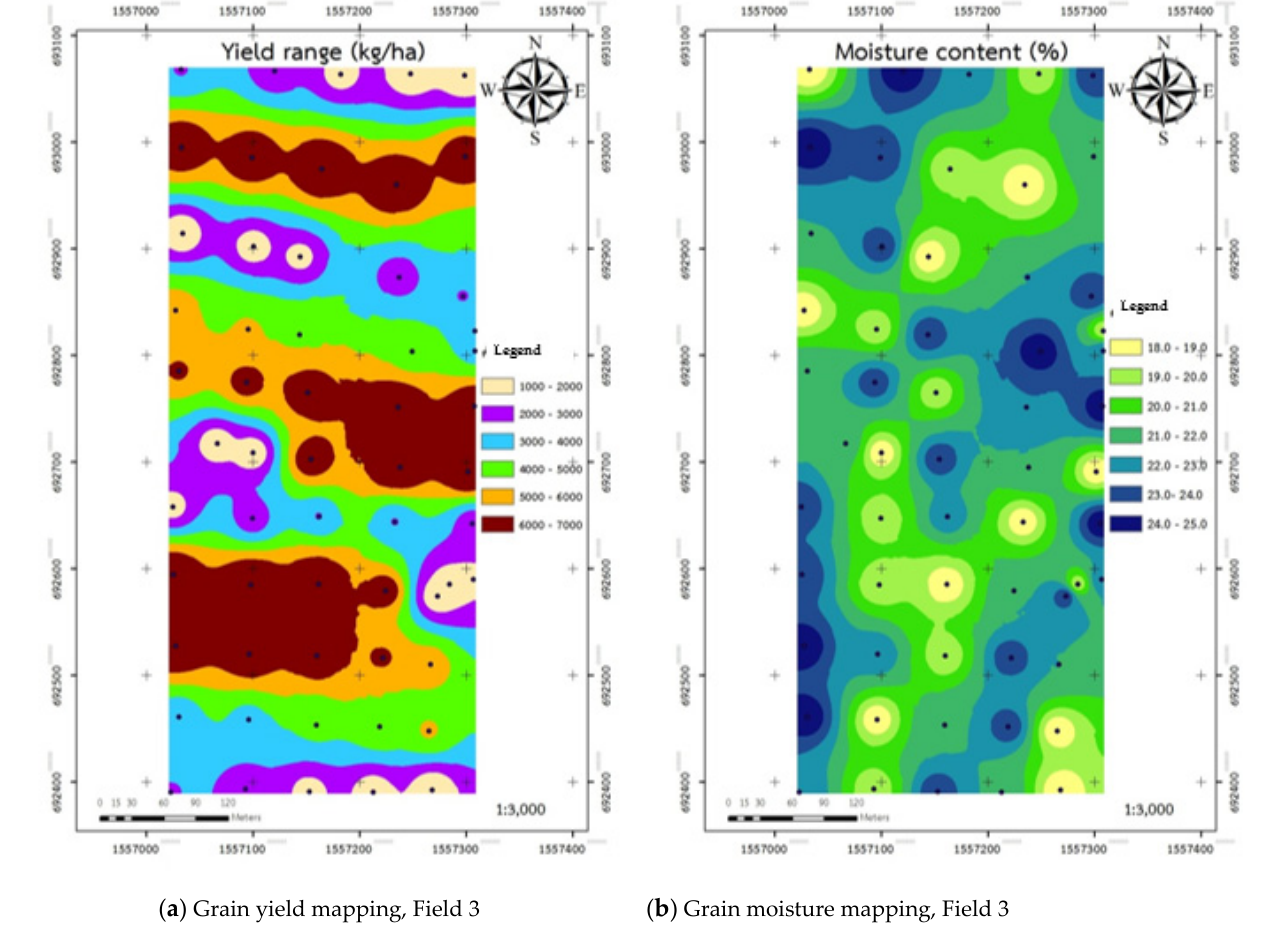
Figure 11. Yield and moisture content variation of plantation of 0.5 ha.